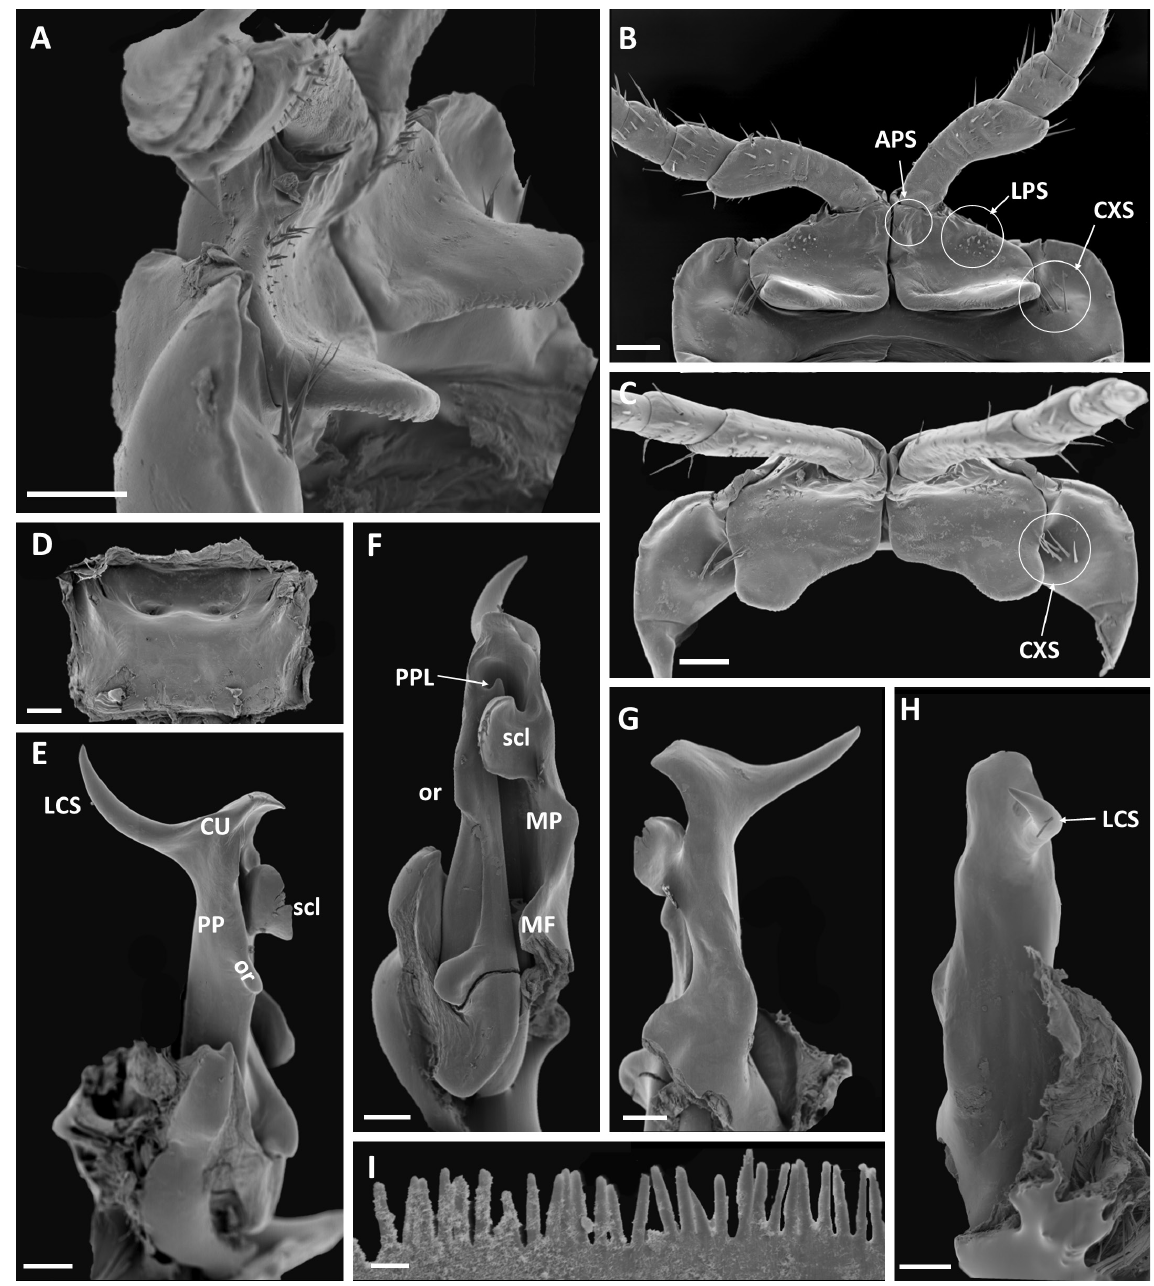
Fig. 75. Xystopyge voluntariorum sp. nov., holotype, ♂ (NHMD 621774). A–C . First pair of legs. A. Sublateral view. B. Anterior view. C. Ventral view. D . Sternum 9. E–H . Left gonopod coxa. E. Anterior view. F. Mesal view. G. Posterior view. H. Lateral view. I . Midbody dorsal limbus. Abbreviations: APS = mesapical prefemoral setae; CU = cucullus; CXS = coxosternal setae; LCS I = Lateral coxal spine; LPS = lateral prefemoral sensilla; MF = metaplical flange; MP = metaplica; or = oblique ridge; PP = proplica; PPL = proplical lobe; scl =semicircular lobe. Scale bars: A–H= 0.2 mm; I = 0.01